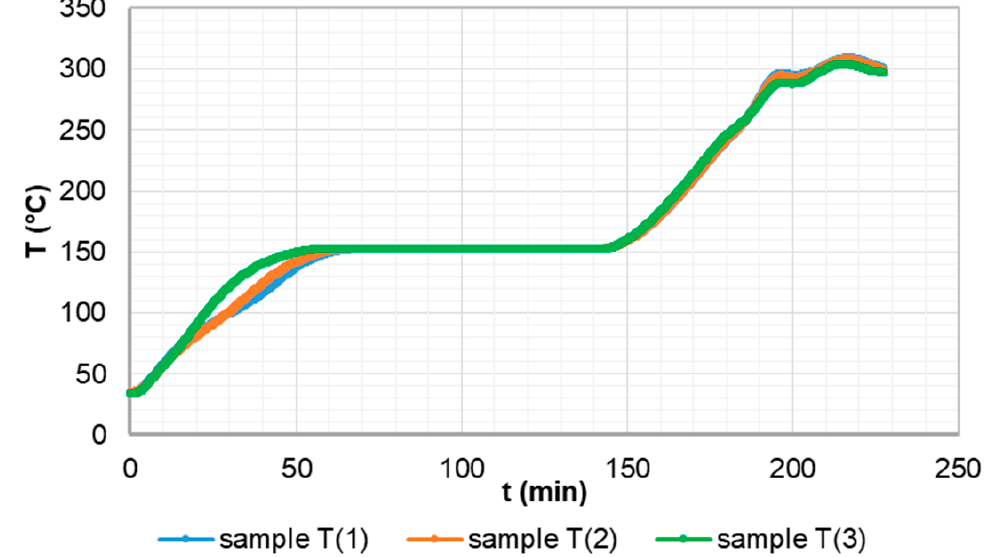
Figure 3. Evolution of the temperatures within the bed of biomass for wheat straw (T 1 at the center, T 2 at the first third of the radius, T 3 at the second third of the radius) for a torrefaction at 300 ◦ C (N 2 , 1